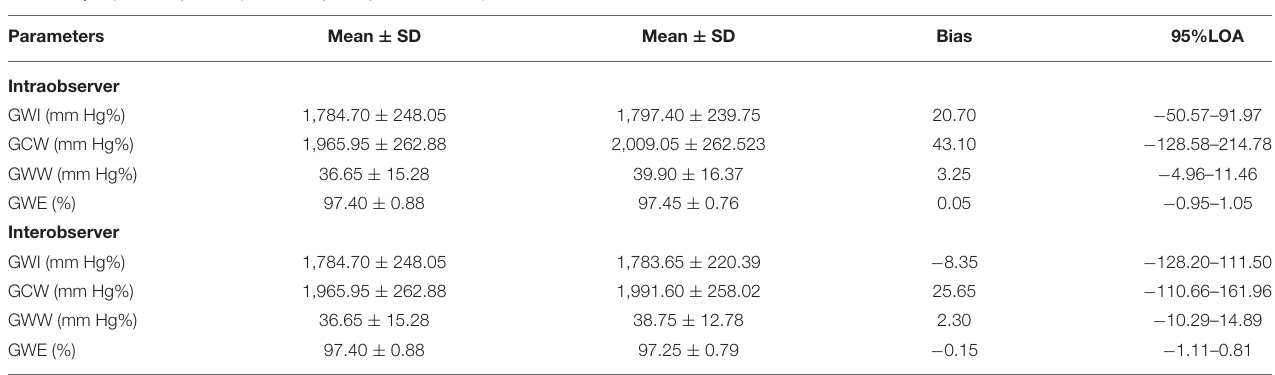
TABLE 6 | Repeatability and reproducibility of myocardial work parameters.